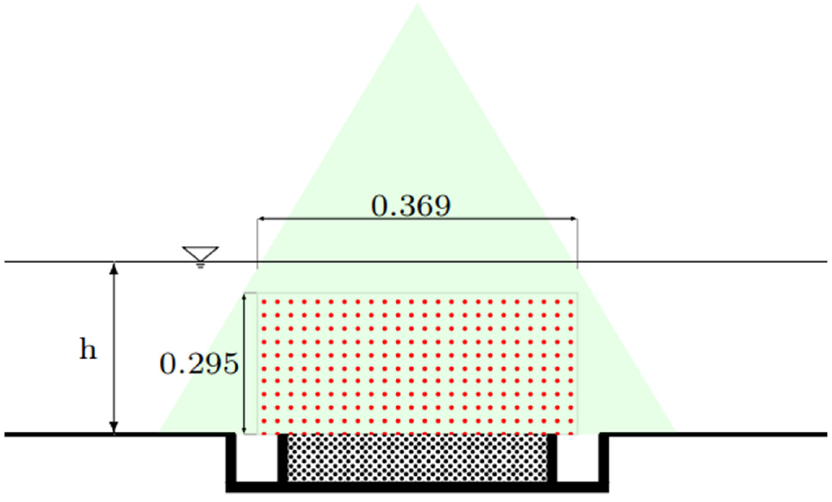
Figure 5. PIV system layout and field-of-view position.